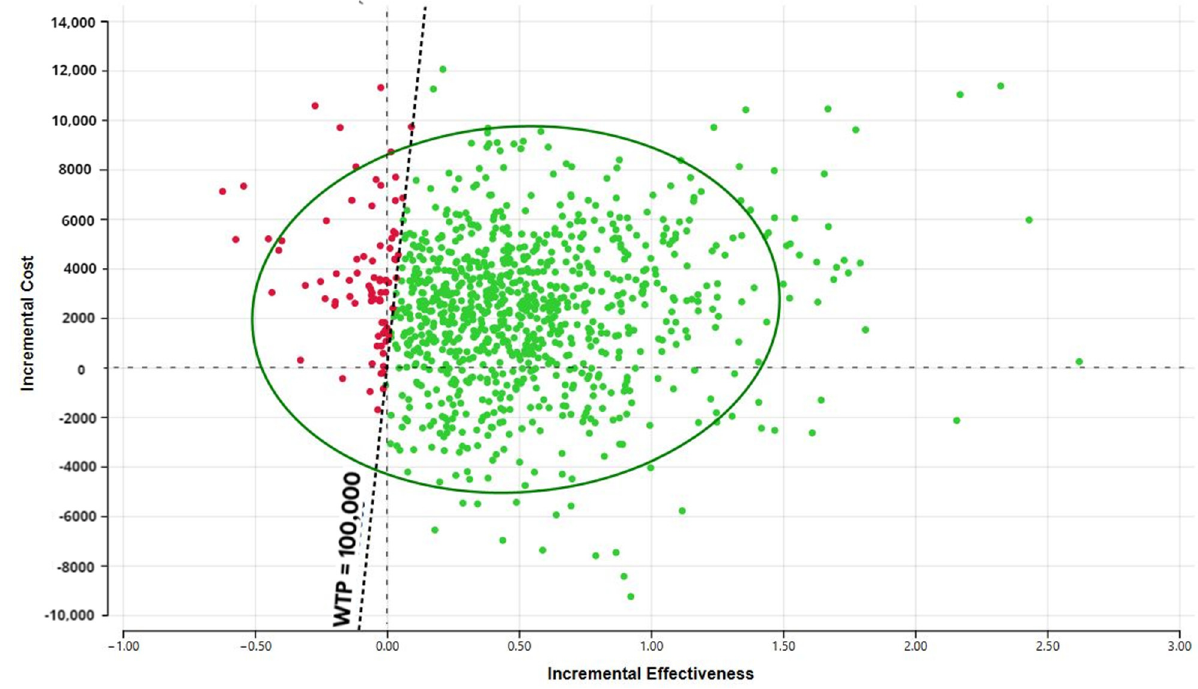
Figure 3. Probabilistic sensitivity analysis.